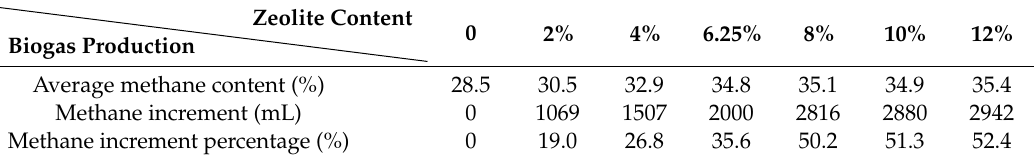
Table 3. Methane increments with di ff erent zeolite dosages.